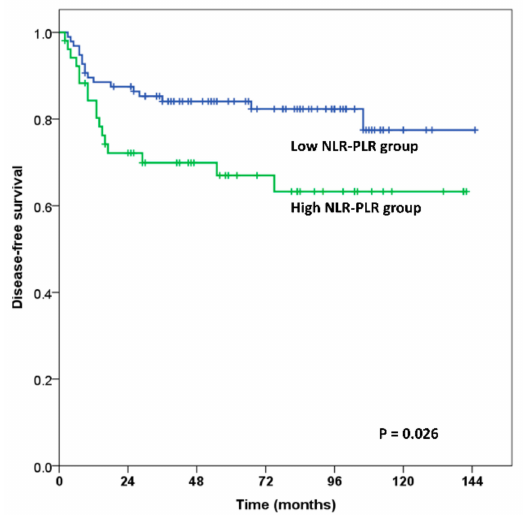
Figure 2. Disease-free survival estimation using Kaplan–Meier analysis. The 5- and 10-year disease- free survival rates for the high NLR-PLR group vs. the low NLR-PLR group were 67.0% and 63.3% vs. and 84.1% and 77.5% ( p =